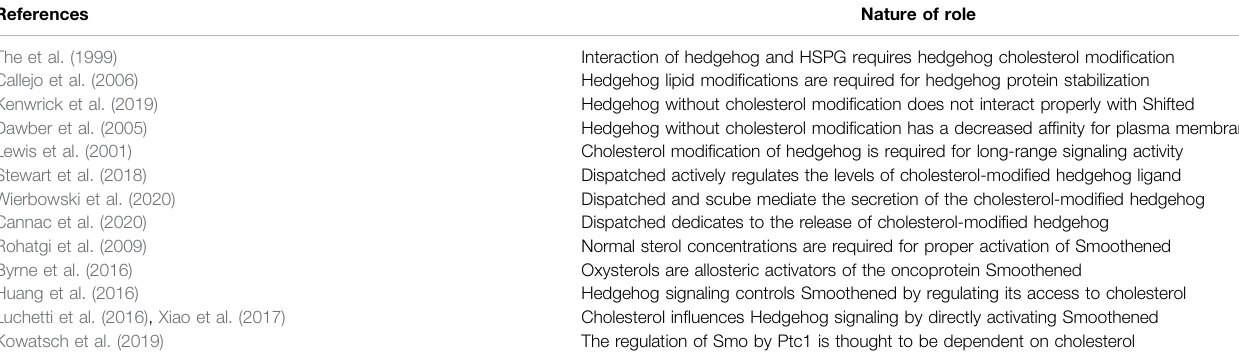
TABLE 1 | Summary of role of cholesterol in HH protein